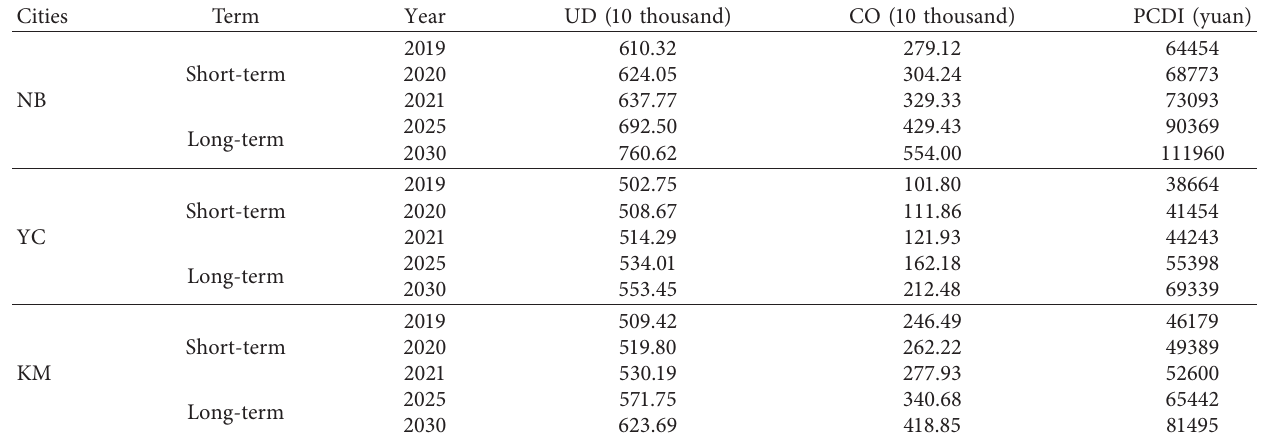
Table 9: Time series prediction for 2019–2021 (conservative).